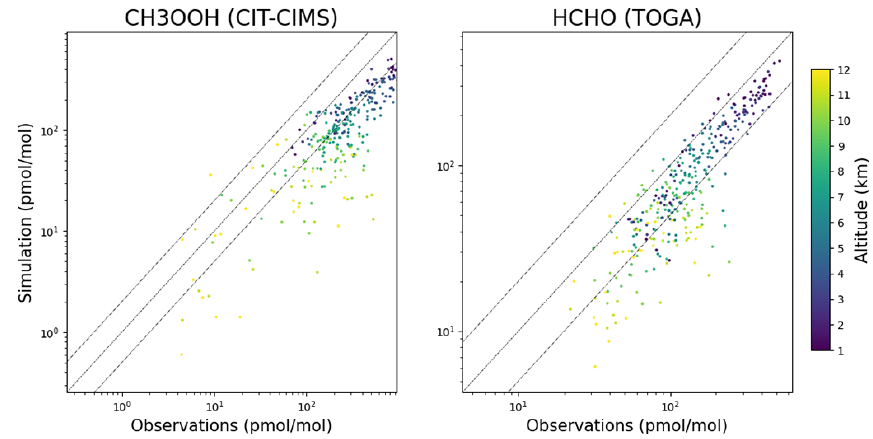
Figure 3. Scattered simulated values of CH 3 OOH and HCHO against the observations of the ATom measurements. The different colours represent the altitude. Both species are generally underestimated by our simulations, but at the same time there is a high correlation between the simulation and observations.